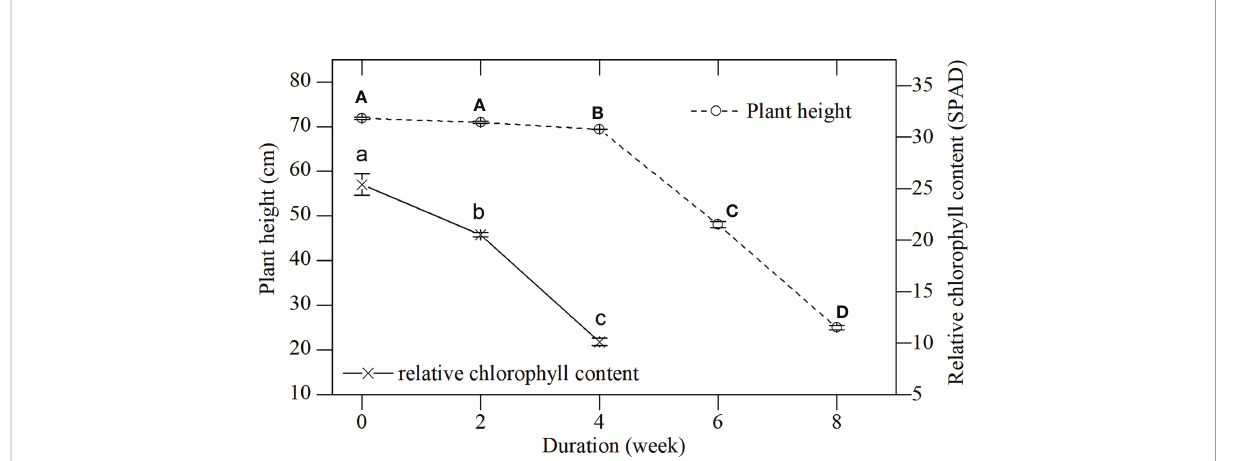
FIGURE 2 Plant height and relative chlorophyll content of L. japonica during the senescence stage. Data are presented as mean ± standard error (SE). Each batch consisted of fi ve replicates. The height and chlorophyll content of each replicate were obtained from 10 stems and 30 leaves. Different capital and small letters indicate signi fi cant differences ( p < 0.05) in plant height and relative chlorophyll content of L. japonica , respectively.